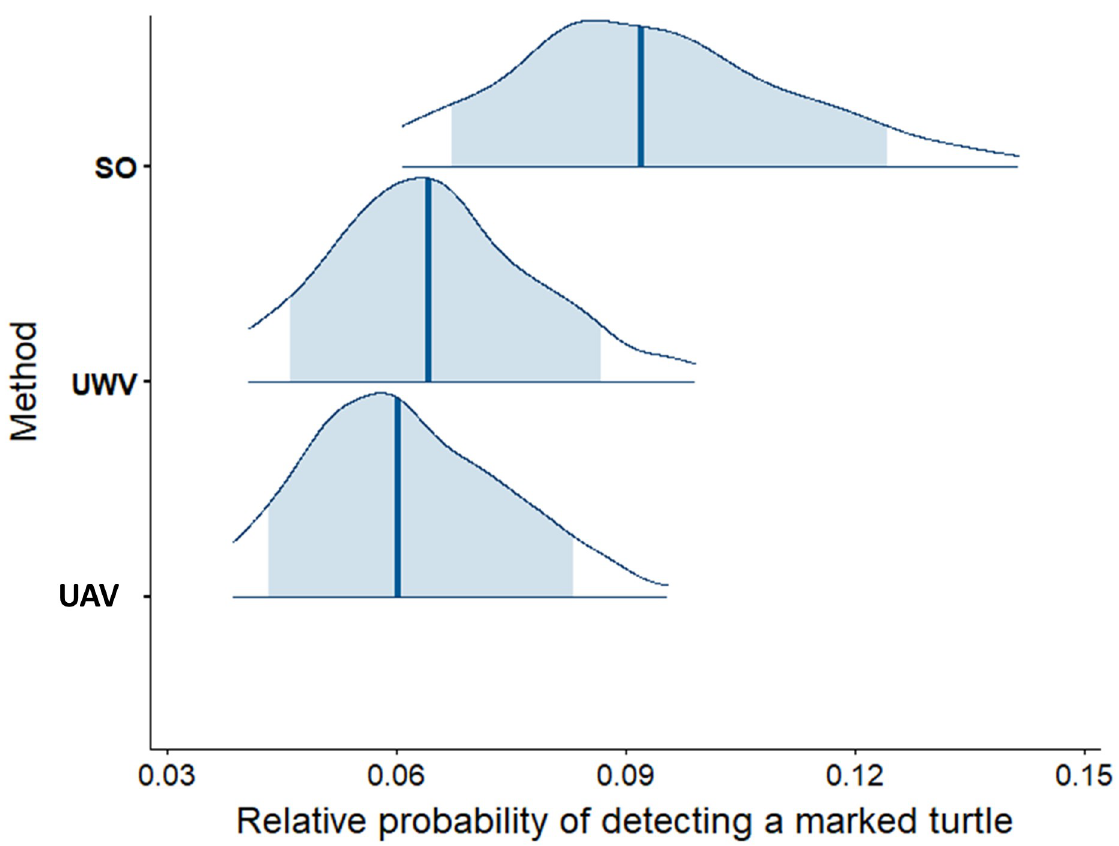
Fig 5. Modelled relative probabilities of detecting marked turtles using each method. (SO, surface observer; UWV, underwater video and UAV). The density plots are computed from the merged posterior draws, where the blue vertical line represents the median and shaded blue areas are the 80% credibility